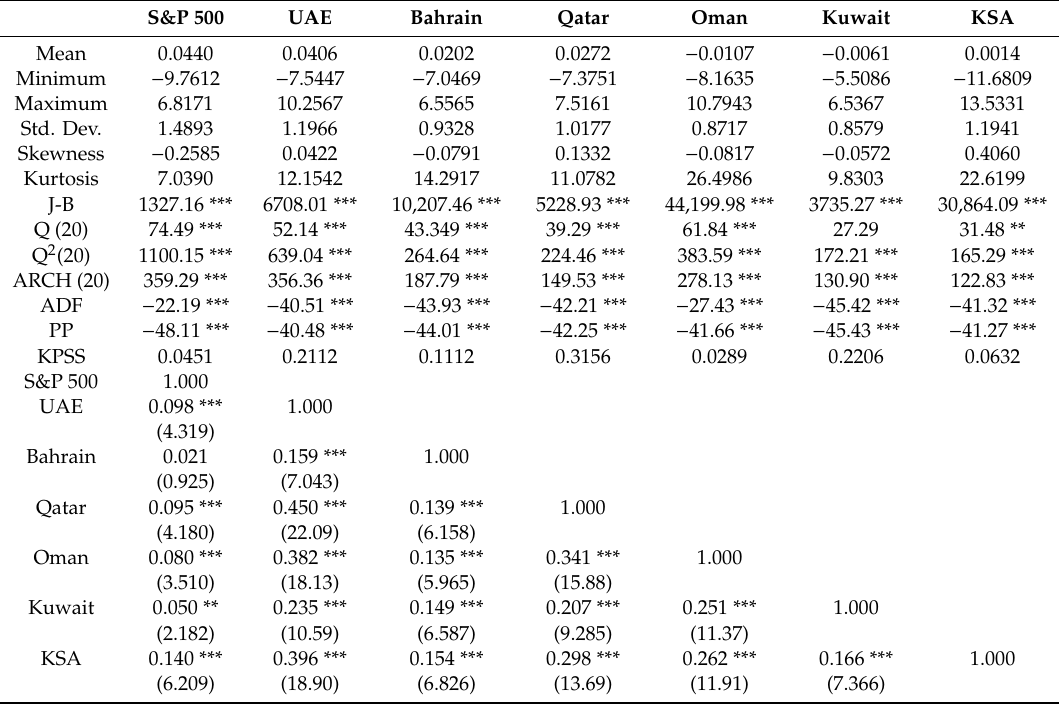
Table 1. Stochastic properties of the banking sector return and the unconditional correlation